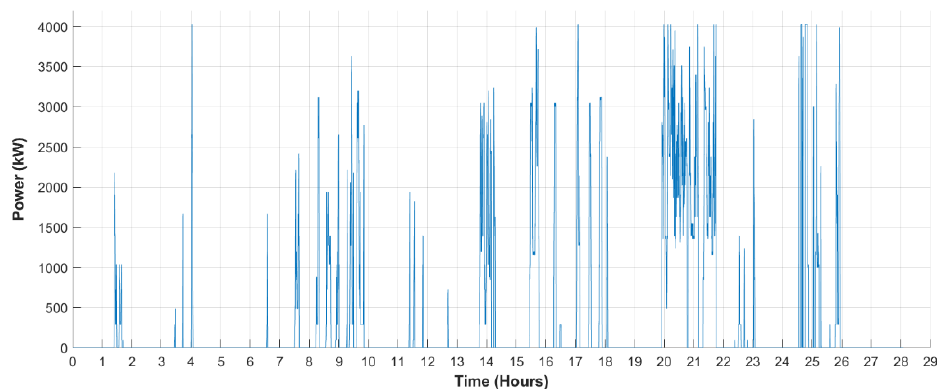
Energies 2020 , 12 , x FOR PEER REVIEW Figure 6. Recovered power (without limit to the storage size). Figure 6. Recovered power (without limit to the storage size).